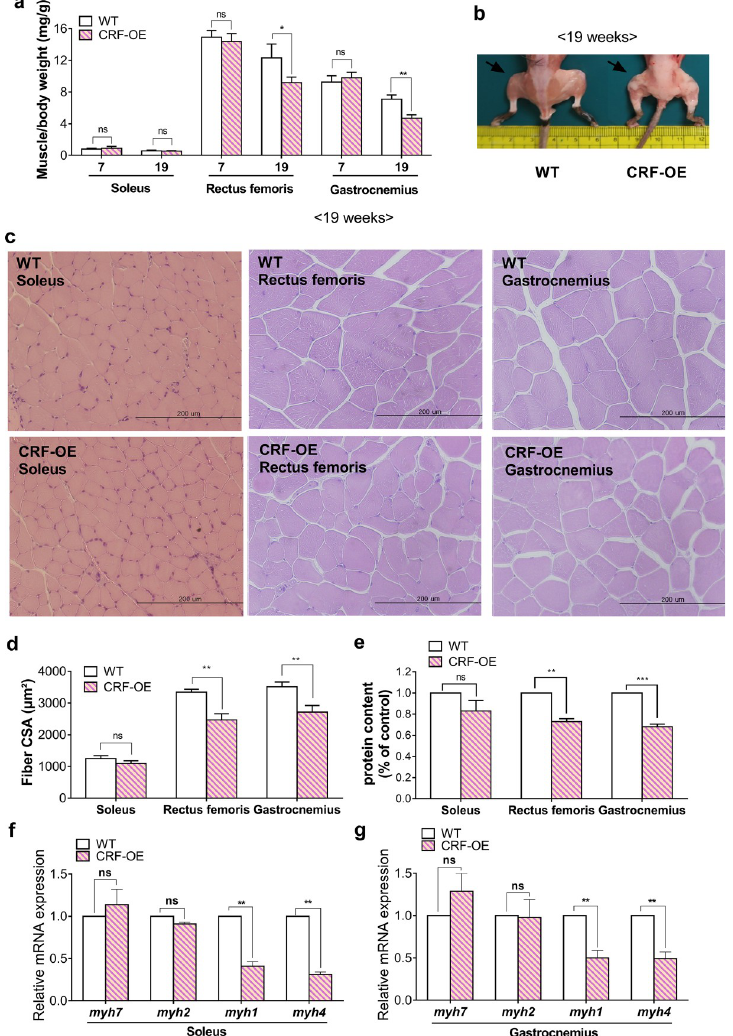
Fig 3. CRF-OE mice exhibited decreased muscle mass and fiber size. (a) Soleus, rectus femoris, and gastrocnemius muscle weights. (b) Image of mouse hindlimbs at 19 weeks. (c) Representative H&E-stained sections, (d) fiber average cross-sectional area (CSA), and (e) total cellular protein of soleus, rectus femoris, and gastrocnemius muscles at 19 weeks. qRT–PCR analysis of mRNA expression of myosin heavy chain genes in (f) soleus and (g) gastrocnemius muscles at 19 weeks. � P < 0.05, �� P < 0.01, and ��� P < 0.001 compared to WT mice. Values represent the mean ± s.e. m (n =